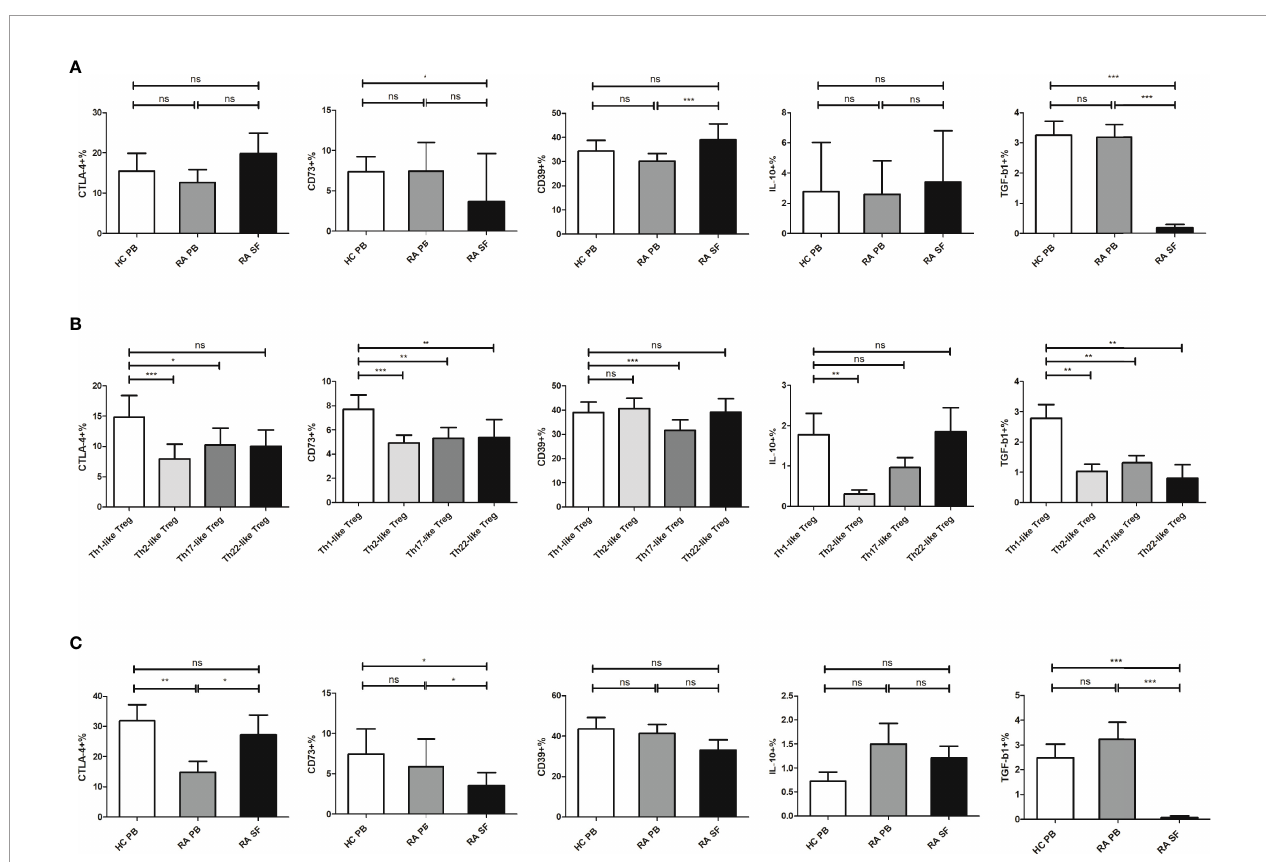
FIGURE 4 | The expression level of different molecules in Treg and its subsets. (A) Comparison of the expression levels of CTLA-4, CD73, CD39, IL-10, and TGF- b 1 in Treg cells from HC PB, RA PB, and RA SF. (B) Comparison of the expression levels of CTLA-4, CD73, CD39, IL-10, and TGF- b 1 in different Th-like Treg cells from RA PB. (C) Comparison of the expression levels of CTLA-4, CD73, CD39, IL-10, and TGF- b 1 in Th1-like Treg cells from HC PB, RA PB, and RA SF. Data are from 48 RA patients, 39 healthy donors and 16 SF samples. * p < 0.05, ** p < 0.01, *** p < 0.001, ns, not statistically signi fi